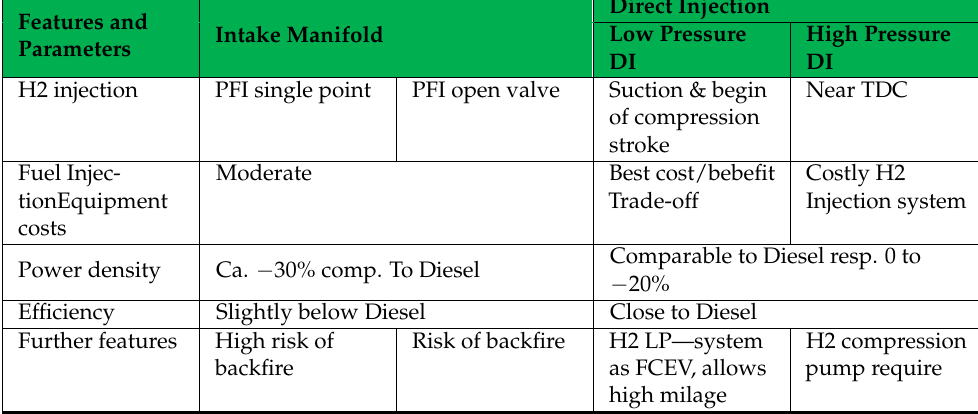
Table 3. Comparison of key features and parameters of PFI and DI fuel systems [98].